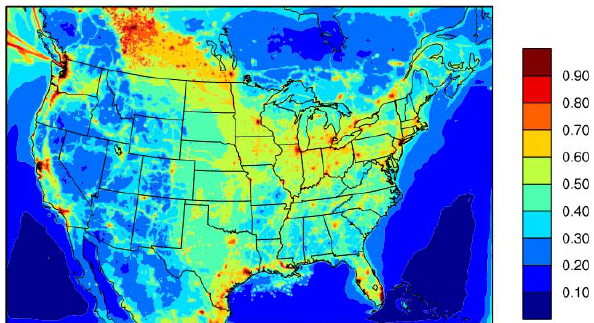
Fig. 9. The fraction of RO 2 reacting with NO (vs. HO 2 ) , indicat- ing the relative importance of high- vs. low-NO x pathways, respec- tively, predicted in the CMAQ simulations averaged over the simu- lation period, 15–31 July 2006.